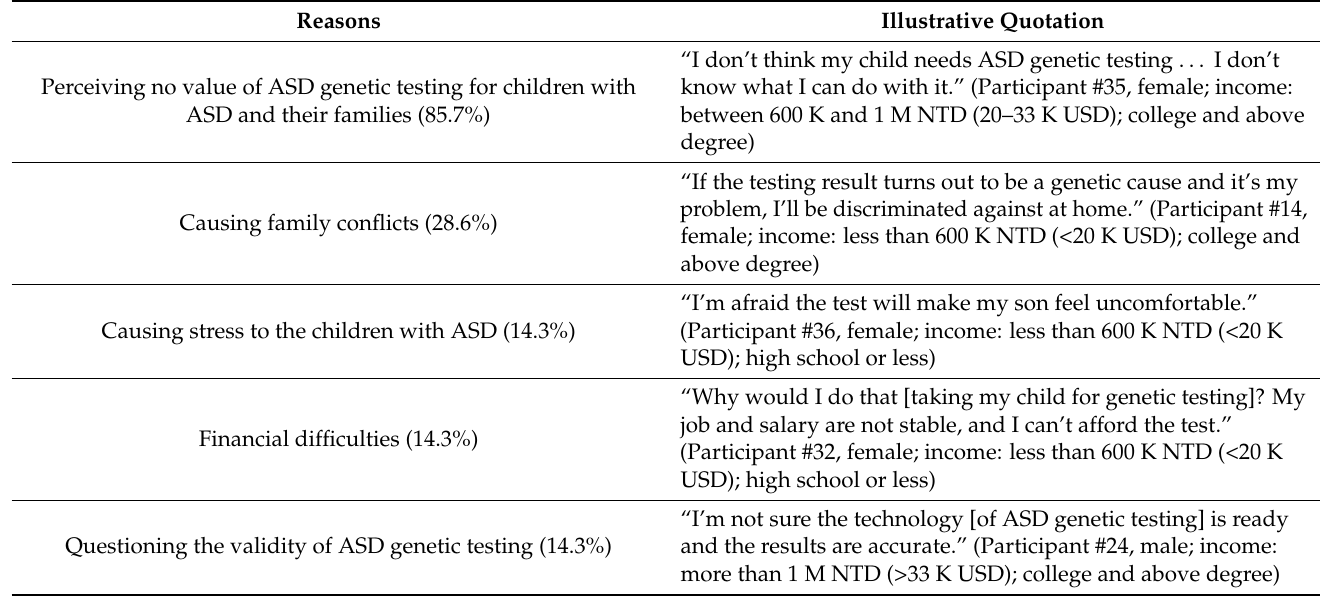
Table 2. Reasons for opposing ASD genetic testing among parents of children with